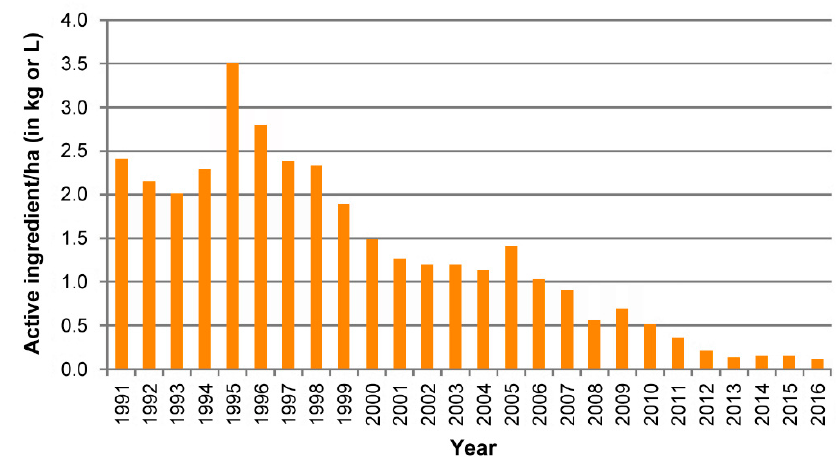
Figure 8. Estimates of pesticide use against the codling moth from 1991 to 2015 in the OKSIR Program area, Okanagan Valley. Sales data for the 15 products registered for the use against codling moth are used to determine these values. However, a number of these insecticides are also used against other pests and/or crops. The proportion of total sales of a given product used against the codling moth is estimated by local tree fruit experts (Jerry Vakenti, BC Ministry of Water, Land and Air Protection; Hank Markgraff, Head of Field Service, BC Tree Fruits; Hugh Philip, IPM specialist, Independent Consultant). The estimates of active ingredients are divided by the area (ha) of planted pome fruit in the program area to account for changes in sales due to the amount of pome fruit under cultivation. From 1991 to 2015, there was an estimated 96% reduction in pesticides used against the codling moth. Other factors, such as changes in application rates in spindle vs. traditional plantings, new product formulations, etc. contribute in part to this reduction (reproduced with permission from OKSIR).